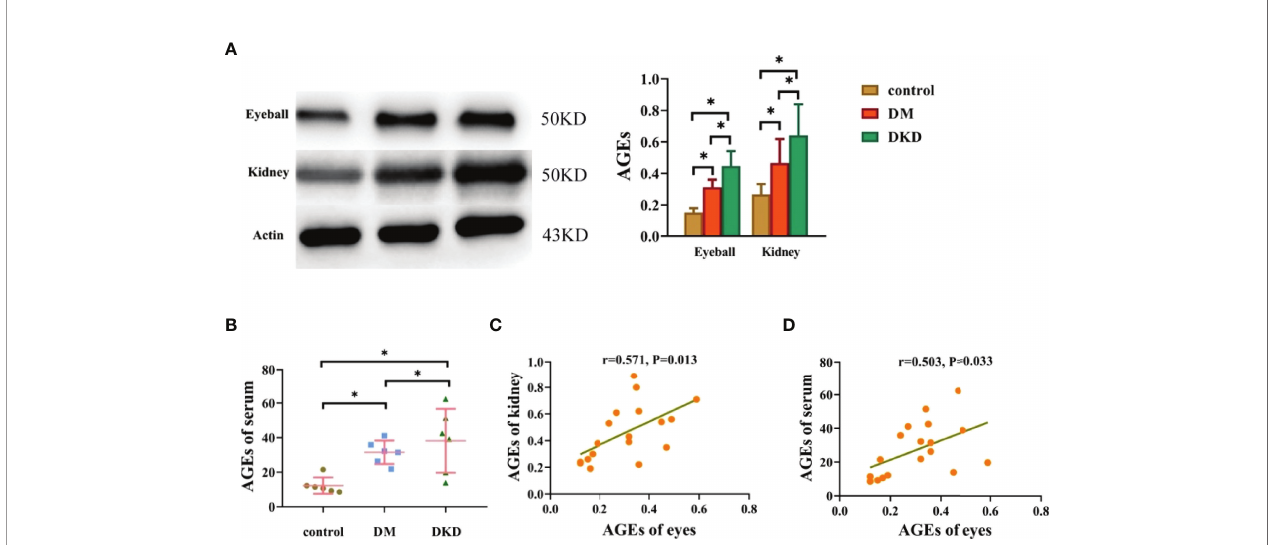
FIGURE 4 | Eyeball AGEs in DKD mice were positively correlated with kidney and serum AGEs (*p<0.01). (A) Representative pictures of eyeball and kidney AGEs in mice in the control group, DM group and DKD group (n =6 mice per group). (B) Representative pictures of serum AGEs in mice in the control group, DM group and DKD group(n =6 mice per group). (C) Correlation analysis of AGEs in the eyes and kidneys of mice (n =6 mice per group). (D) Correlation analysis of AGEs between the eyes and serum (n =6 mice per